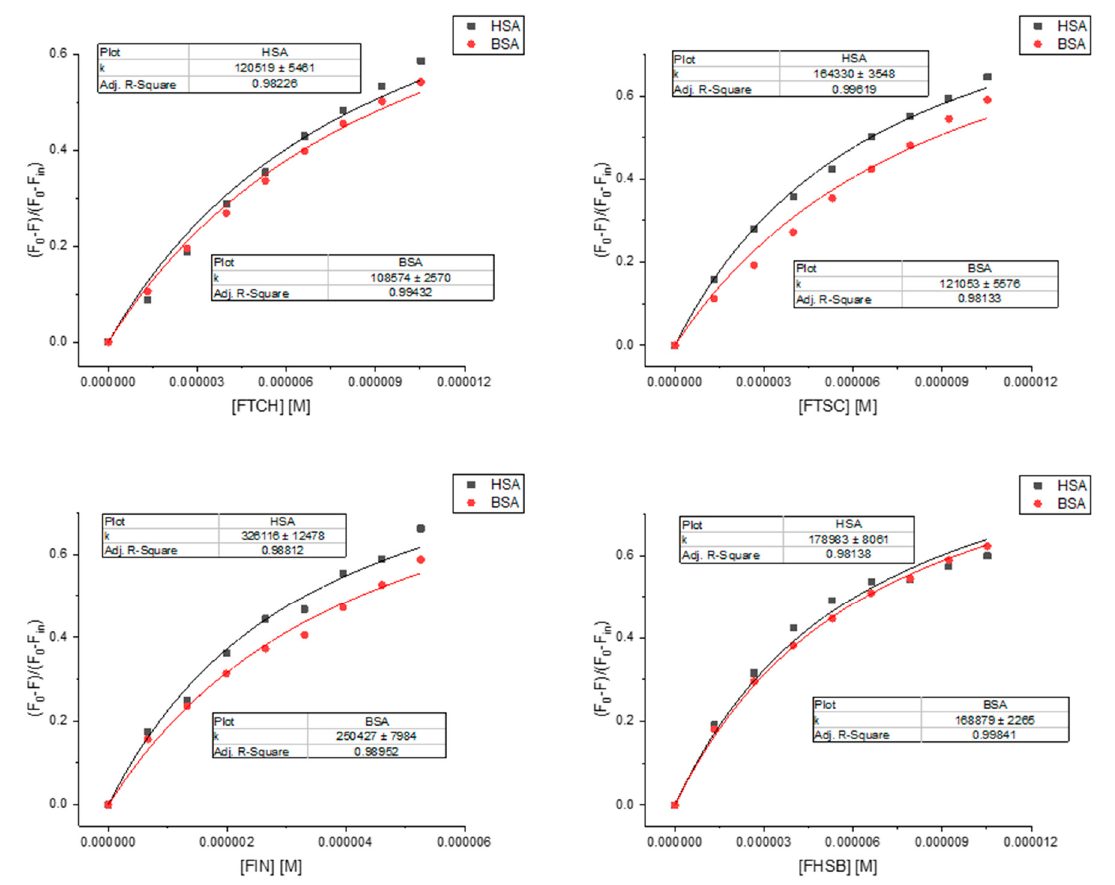
Figure 8. Binding curves fitted by Equation (S14). Table 4. Binding constant and Gibbs Energy for FTCH, FTSC, FIN, and FHSB to HSA and BSA.